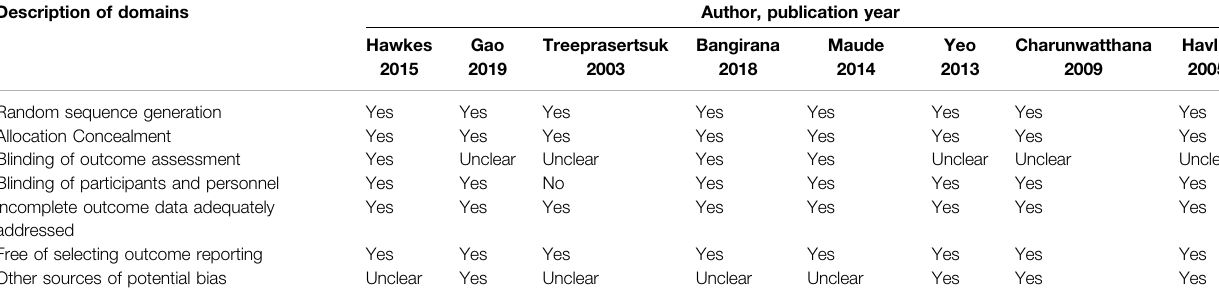
TABLE 2 | The risk of bias of the included